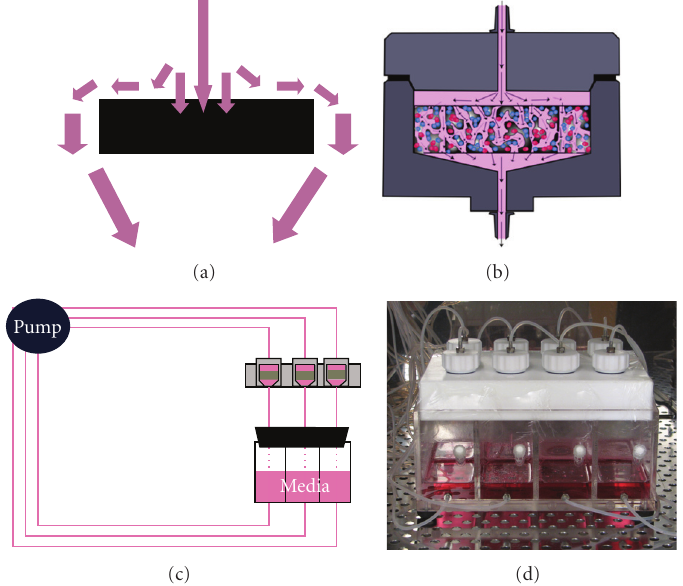
Figure 1: (a) With increased medium fluid flow across the external surface of the sca ff old, chemotransportation is not guaranteed within the porous confines of the sca ff old interior. (b) Schematic chamber within the flow-perfusion bioreactor. Note that medium is forced to percolate through the sca ff old interior, ensuring chemotransportation to cells within the core. (c) Schematic of the 8-chamber flow-perfusion bioreactor within a standard cell culture incubator. (d)